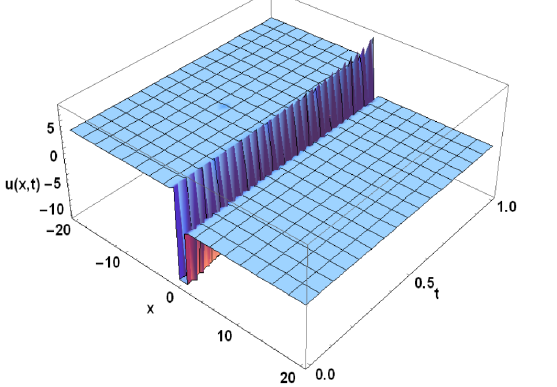
for 3D and 1  t for 2D plots. 3D and t = 1 for 2D plots.